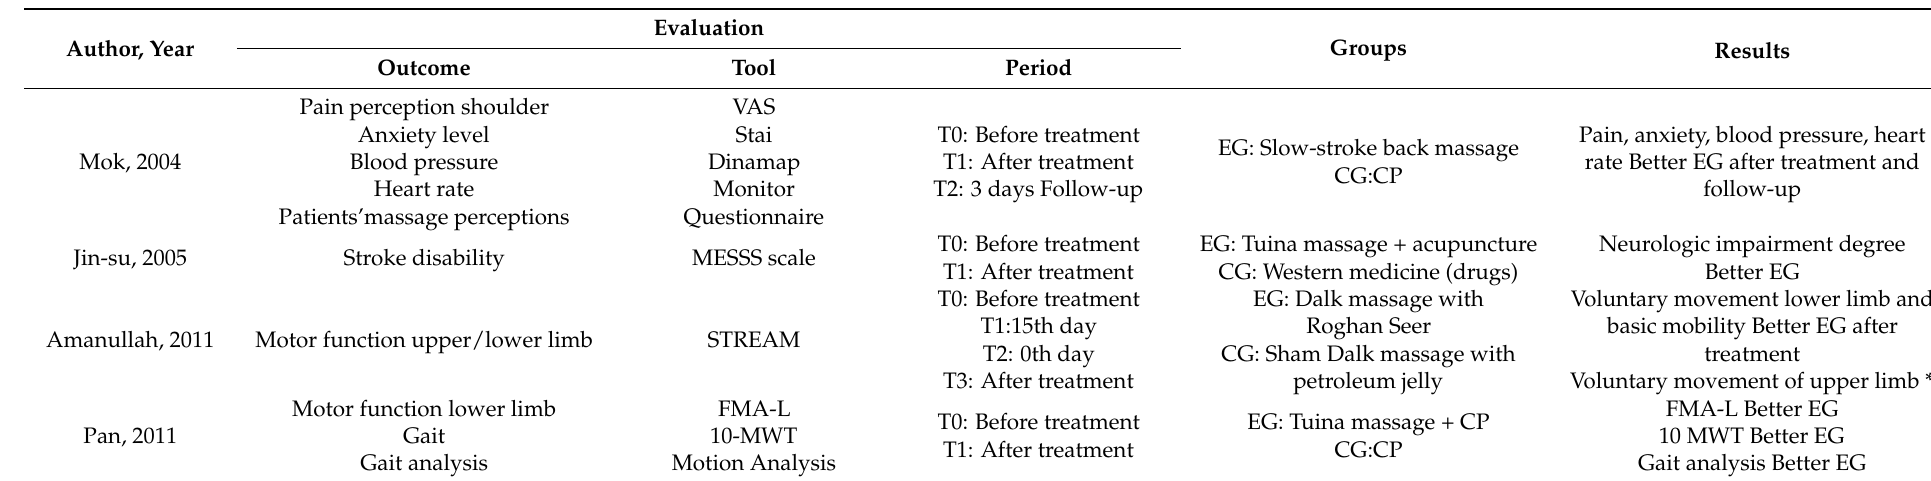
Table 2. Assessment of outcomes and